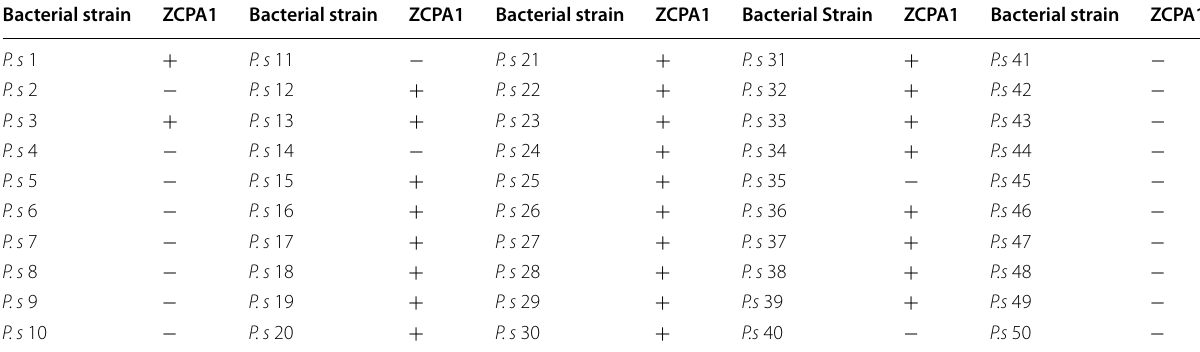
indicates lysis, and +